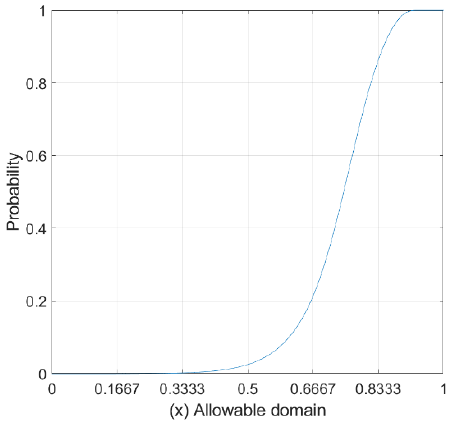
Figure A2. Sample image of a